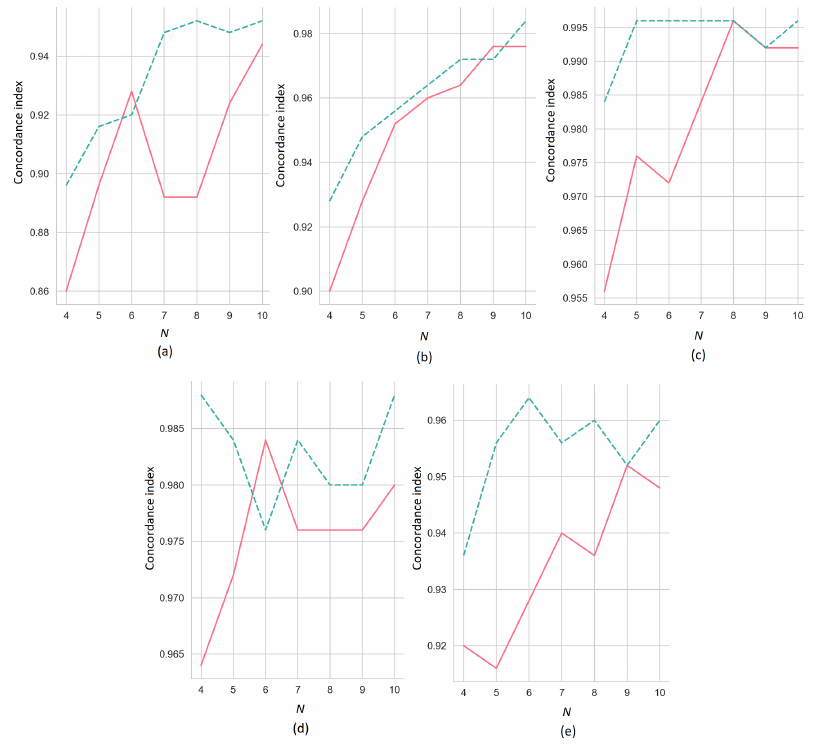
Figure 8. Concordance indices of ERW-SHAP as functions of N for t = 2 (the solid line) and 3 (the dashed line) and for five datasets depicted in corresponding Figure 4a–e and trained